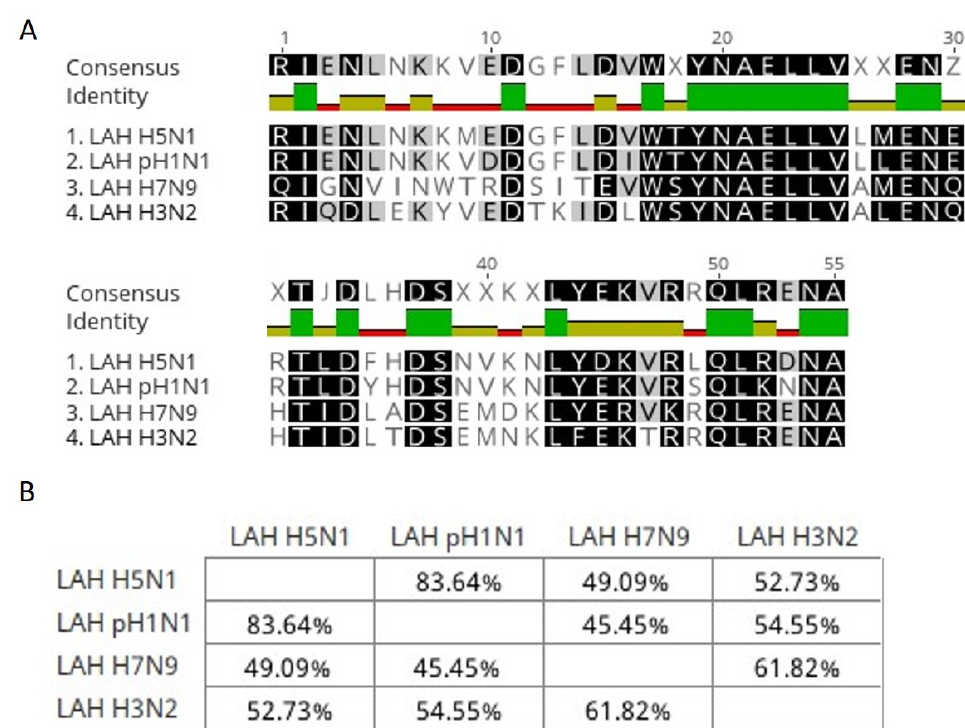
Figure 10. Alignment of amino acid sequences coding LAH regions from H5N1, pH1N1, H7N9 and H3N2 HA protein. ( A ) Alignment view with consensus sequence where the highest similarity is shown as a green colour. ( B ) Matrix showing the percentage of sequence identity between sequences.